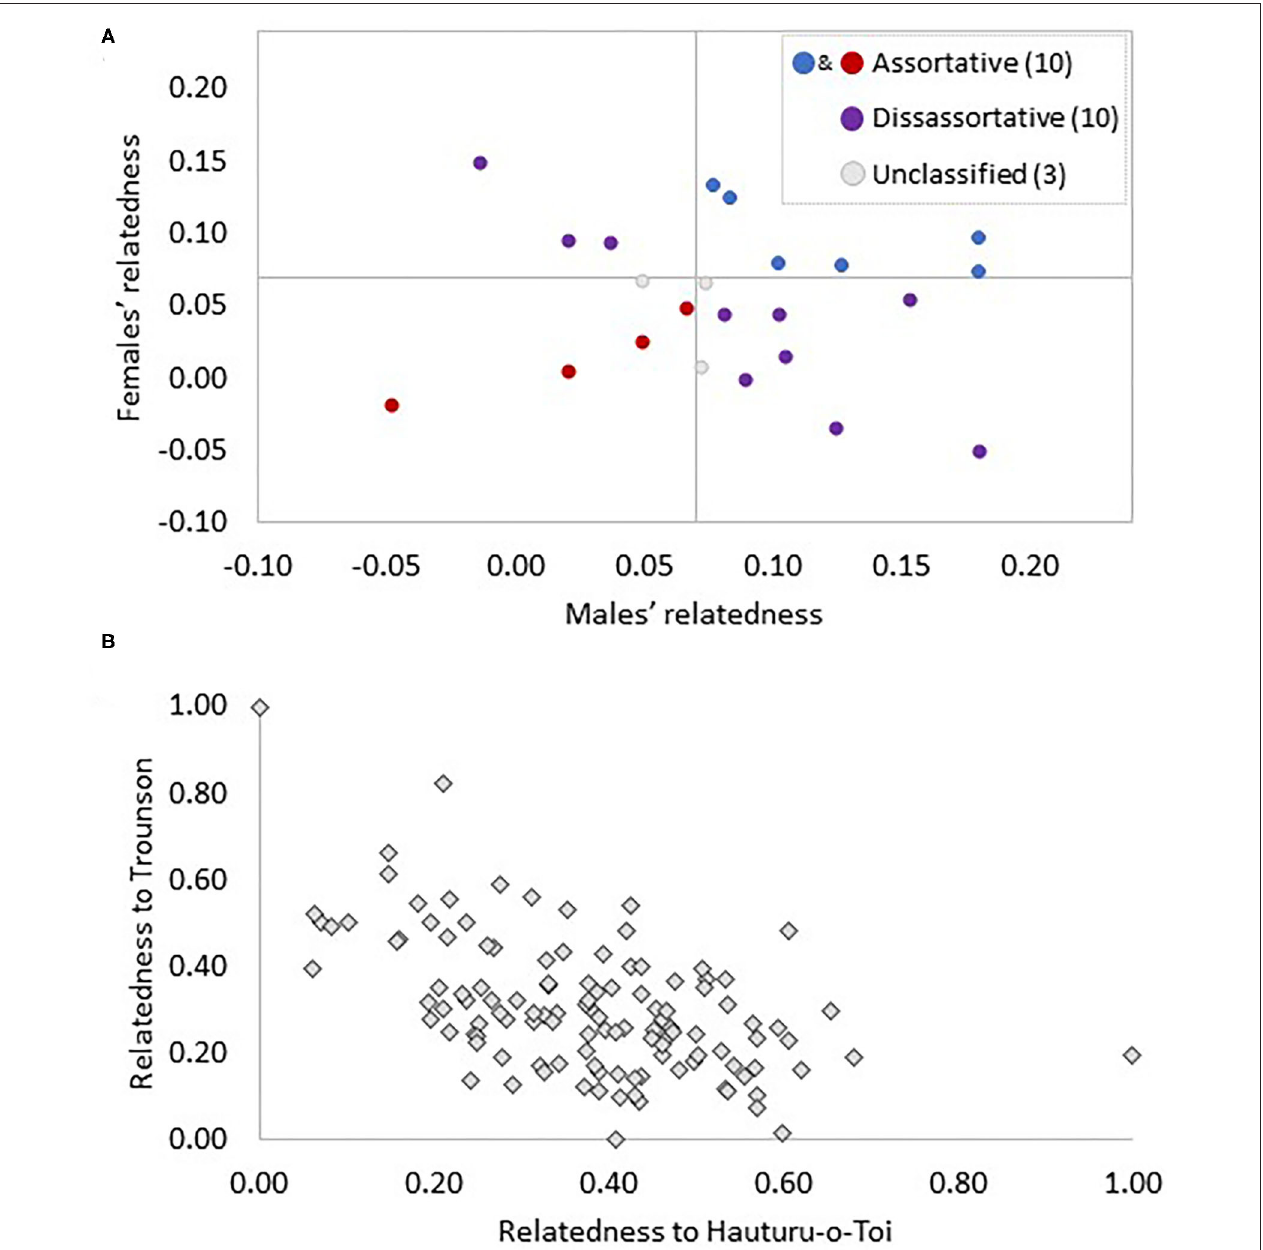
FIGURE 5 | Illustration of the genetic makeup of Ponui Island pairs (A) and the Ponui Island population overall (B) . In panel (A) 23 Ponui Island pairs are represented by one dot each and grey lines divide the graph into quadrants using the average relatedness of 106 Ponui Island birds to the Hauturu birds as a threshold value. In pairs falling in the lower left quadrant (red dots), both the male and female are less related to Hauturu than the average Ponui Island bird and, thus, are classified as “assortative” or “similar”. Pairs in the upper right quadrant (blue) are also “assortative” or “similar” (both less related to Hauturu than the average Ponui Island bird), while the top left and bottom right quadrant contains pairs where the male and the female fall on opposite sides of the threshold and are, hence, referred to as “disassortative” or “different” pairs (purple). Three pairs fall on the threshold value and remain unclassified (grey). In panel (B) each of the 106 Ponui Island birds is represented by a diamond indicating their normalised relatedness to Hauturu and Trounson birds. Relatedness values were spread uniformly across the gradient, i.e., the scatter plot indicates no genetic clustering suggestive of positive assortative